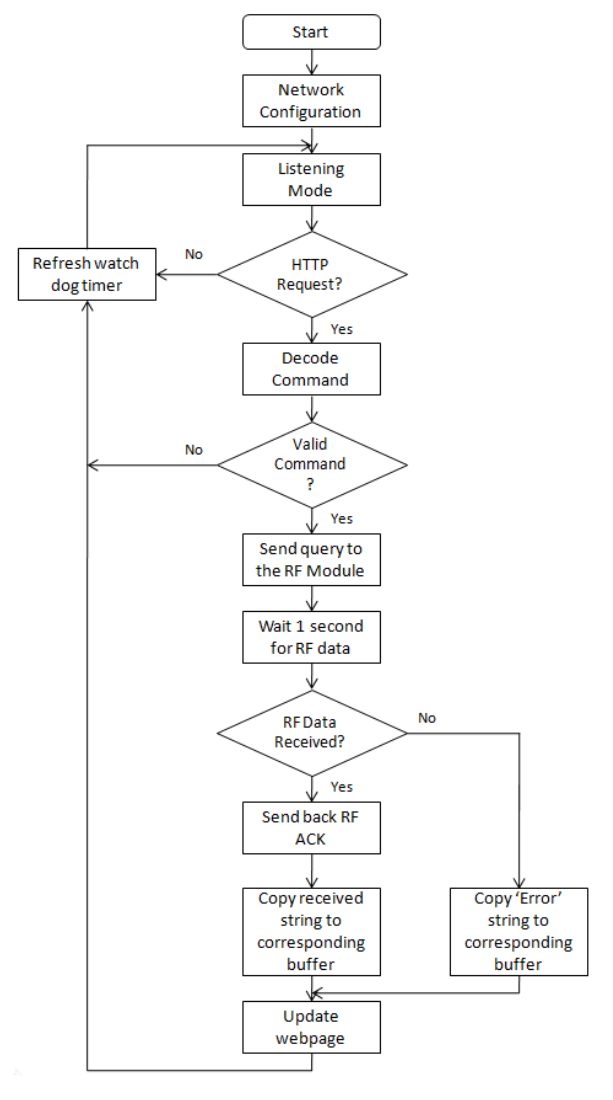
Figure 10. Flow diagram for the main routine in the remote base